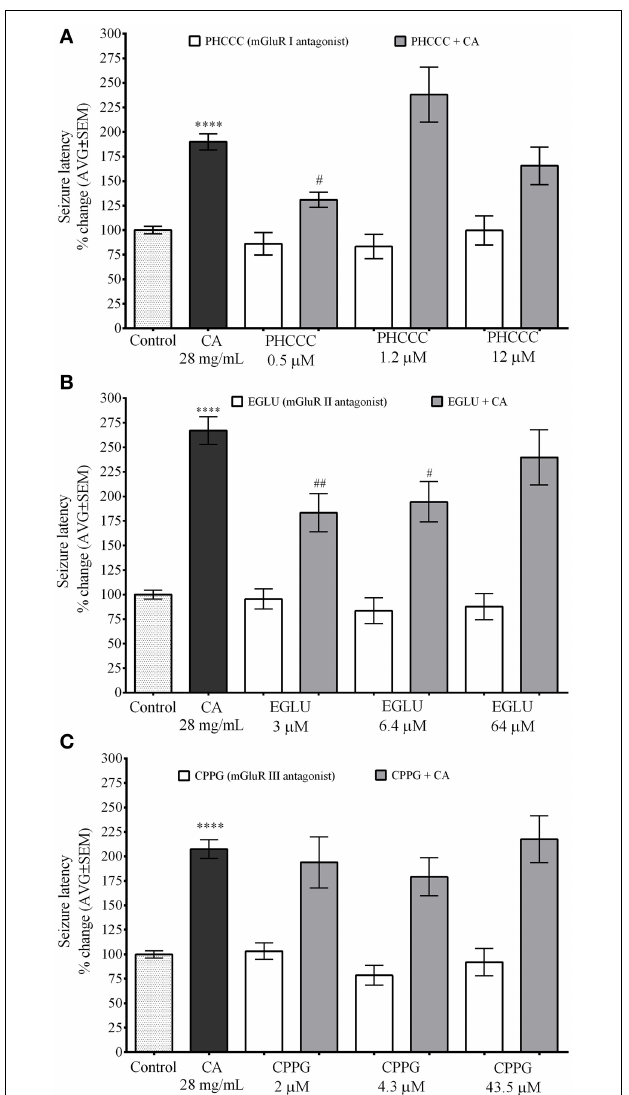
FIGURE 6 | Selective In vivo interaction of C. aurantium extract with mGluR. Fish were allowed 1h absorption of various concentrations of selective mGluR antagonist PHCC(mGluRI), EGLU(mGluRII), CPPG(mGLURII) followed by 1h absorption on C. aurantium extract 28mg/mL prior exposure to PTZ 3mg/mL. (A) PHCC at 0.5 μ M significantly reduced seizure latency by 32% and at 1.2 μ M significantly increased seizure latency by 38% when compared to C. aurantium alone. (B) EGLU 3 and 6.4 μ M, significantly reduced the increase in seizure latency caused by treatment with C. aurantium extract by 33 and 29%, respectively. (C) mGluR III antagonist CPPG had no effect on the changes in seizure latency caused by exposure to C. aurantium extract. Results are shown as average ± SEM of at least three experiments, n > 12. ∗∗∗∗ vs. Naive P < 0 . 0001, # vs. C. aurantium 28mg/ml P < 0 . 05; ## P < 0 .